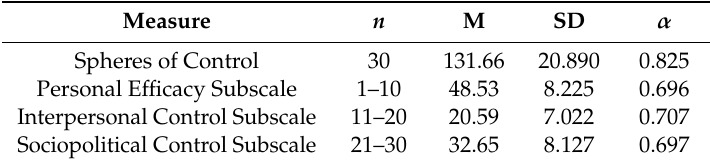
Table 5. Summary of the Spheres of Control